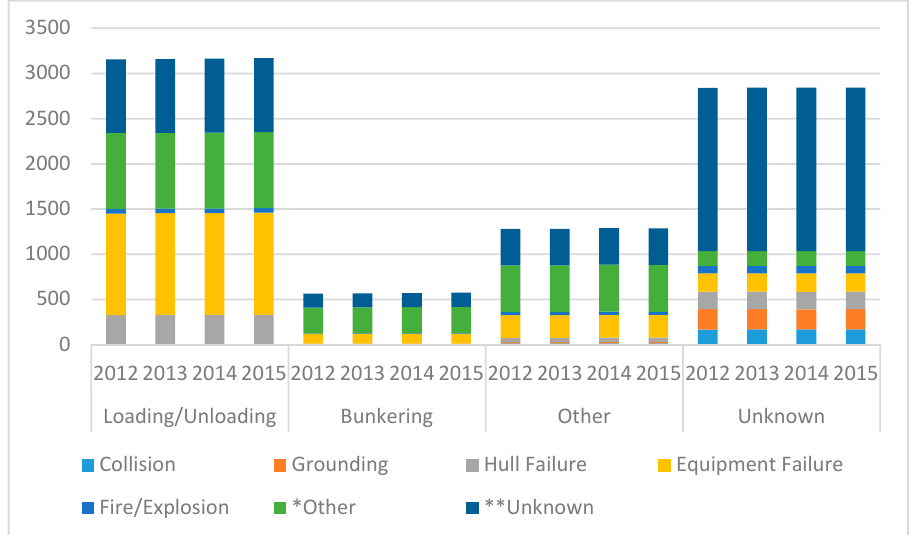
Table 3. Statistics on oil spills of less than 7 tons from 2012 to 2015.